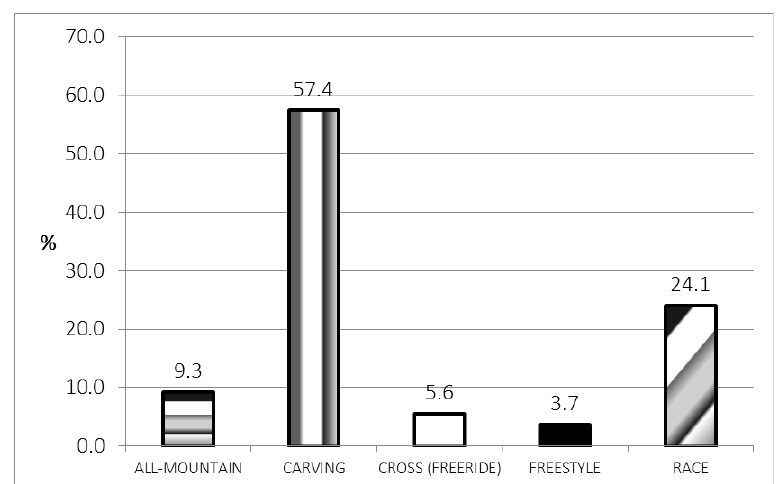
Figure 1. Percentage (%) of selection for the type of skis by the tested.